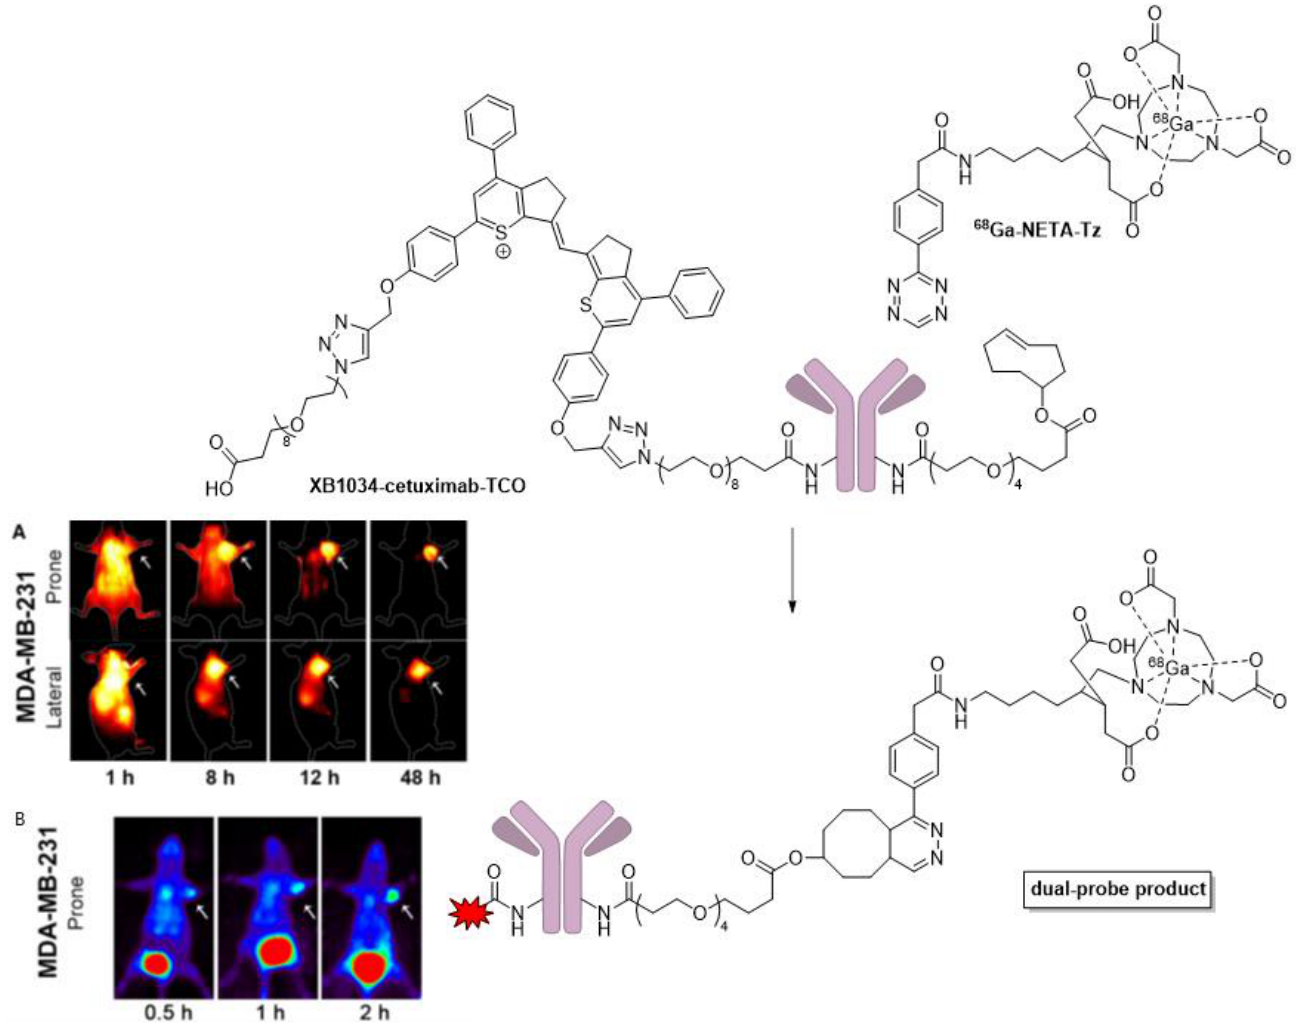
Figure 12. Structures of XB1034-cetuximab-TCO and 68 Ga-NETA-Tz . NIRF imaging ( A ) and PET images ( B ) in MDA-MB231 xenograft tumors at various time points after 68 Ga-NETA-Tz injection (Reprinted from Ref. [57]. Copyright 2020, FEBS Press and John Wiley & Sons Ltd.)